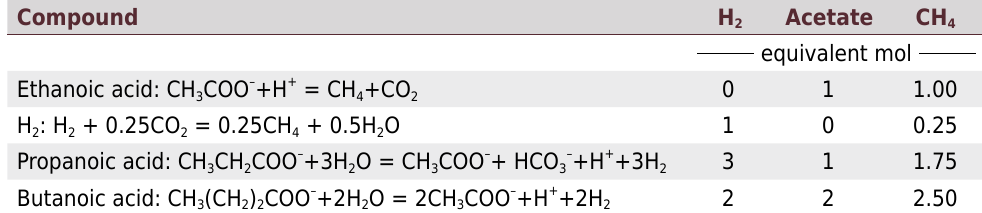
Adapted from Kotsyurbenko et al.